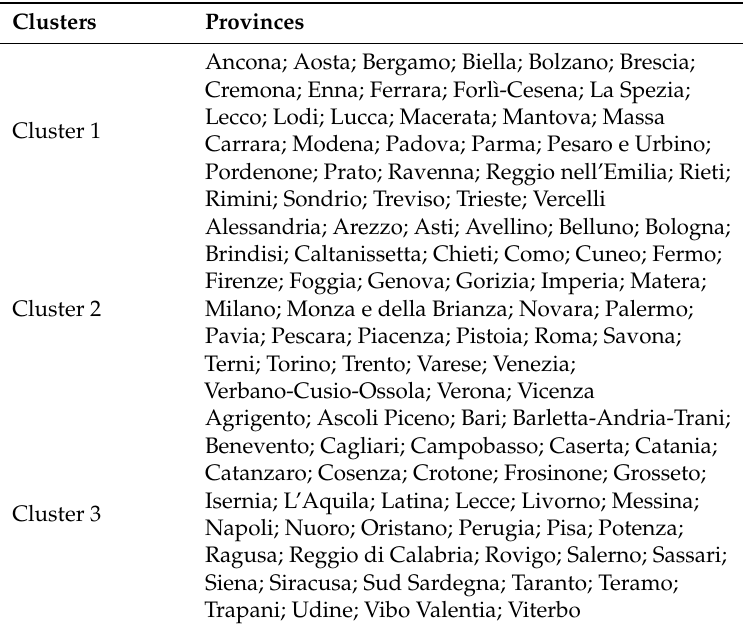
Table 7. K-means clusters’ composition of